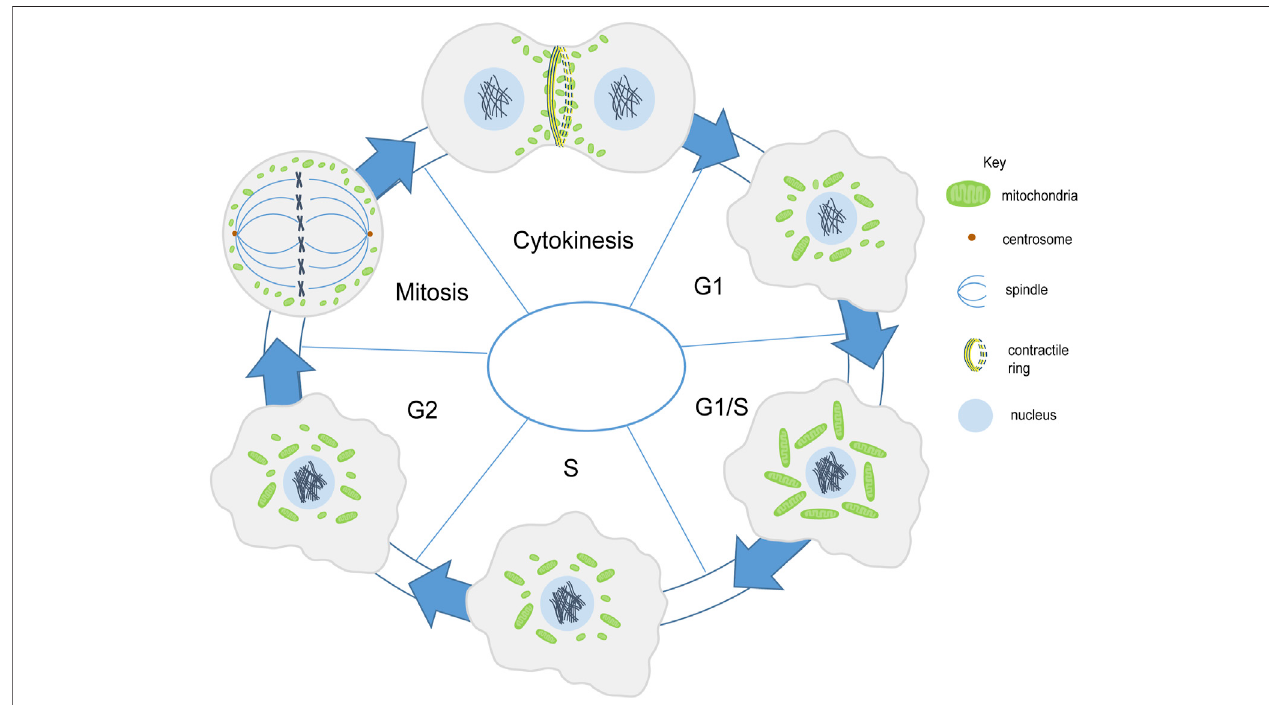
FIGURE 2 | Mitochondria shape change during cell division. Mitochondria (green) are present in fragmented and intermediate morphology during the G1 phase. They form a tubular network in the G1/S phase. In the S phase they become fragmented or have an intermediate morphology (Finkel and Hwang, 2009; Mitra et al., 2009). Mitochondrial membrane potential increases along with mitochondrial elongation from G1 to G2/M phase (Martínez-Diez et al., 2006). Mitochondria get fragmented during mitosis and are further distributed among the daughter cells (Taguchi et al., 2007). Mitochondria align the contractile ring during cytokinesis (Lawrence et al.,